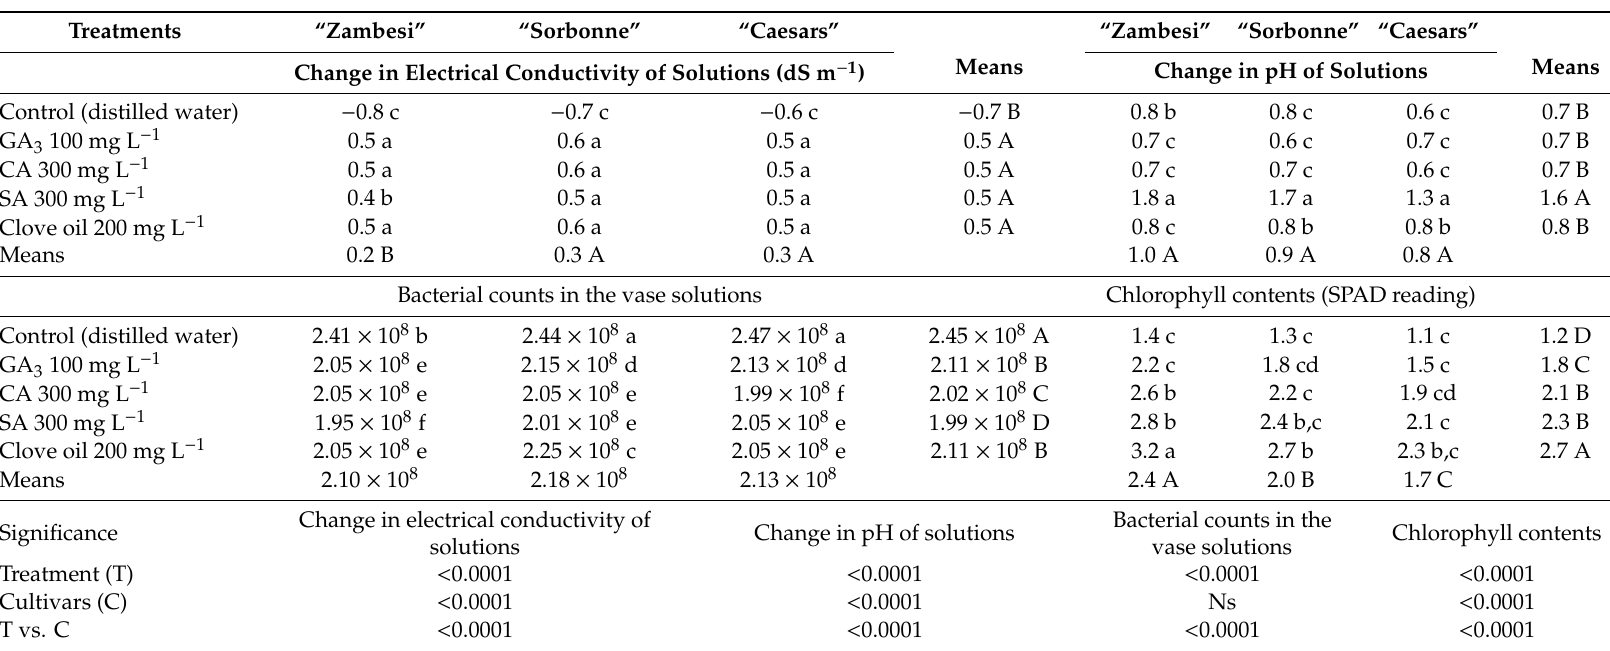
Table 3. Comparative analysis of the e ff ects of di ff erent vase solutions on the change in electrical conductivity of the solutions, change in pH of the solutions, bacterial counts in the vase solutions, and chlorophyll contents of the petals of three cultivars of cut lily flowers.